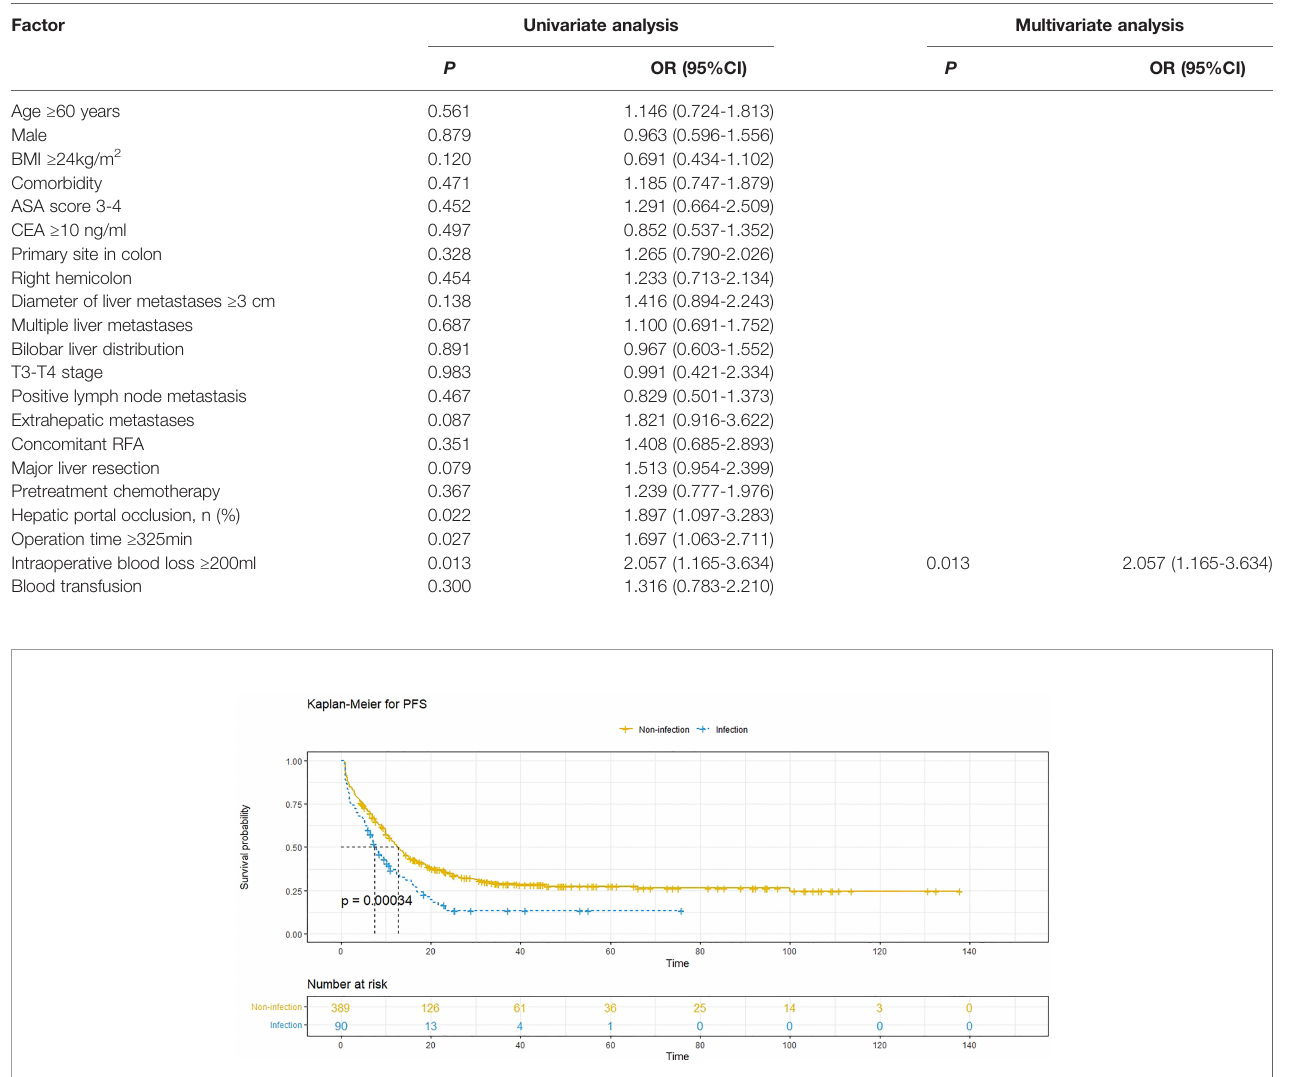
FIGURE 1 | Progression-free survival (PFS) comparison in patients with postoperative infective complications (blue line) and patients without postoperative infective complications (yellow line). Infection, postoperative infective complications. Non-infection, without postoperative infective complications.